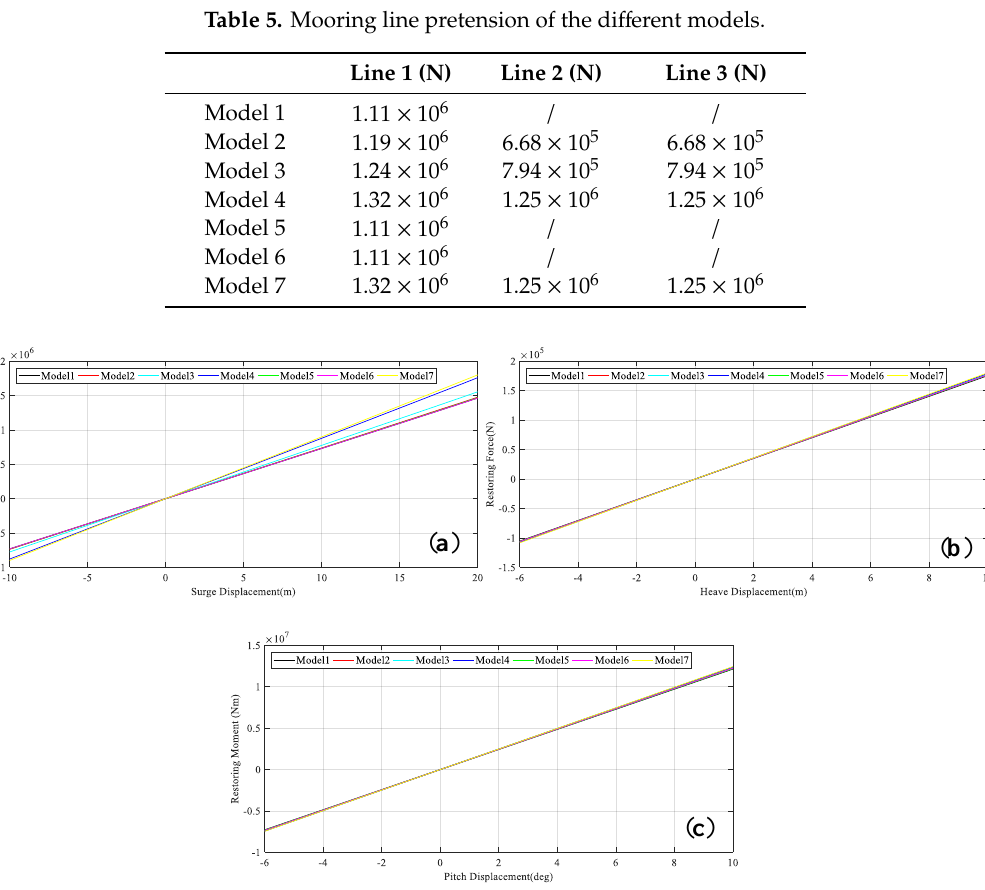
Table 5. Mooring line pretension of the di ff erent models.